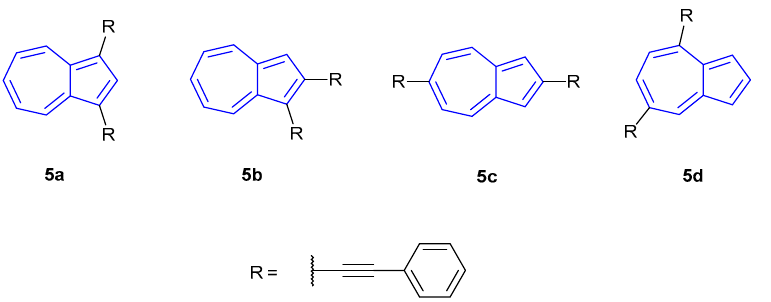
Figure 5. Di(phenylethynyl) azulene species developed by Venkatesan et al. in 2013 [50]. In 2015, Belfield et al. showed that 4-styrylguaiazulene derivates ( 6a – 6l , Figure 6) were also able to show NIR fluorescent emission upon protonation of the guaiazulene core [51]. Similar to the work published by Venkatesan et al. in 2012, the nature of the absorption and emission of the guaiazulene derivatives was tuned by altering the nature of the attached conjugated aromatic system. Neutral species 6a – 6l were found to display weak S 1 → S 0 fluorescent emission in DCM. Protonation of all species afforded a fluorescence turn-on response, with accompanying red-shift of emission. Significant Stokes shifts were